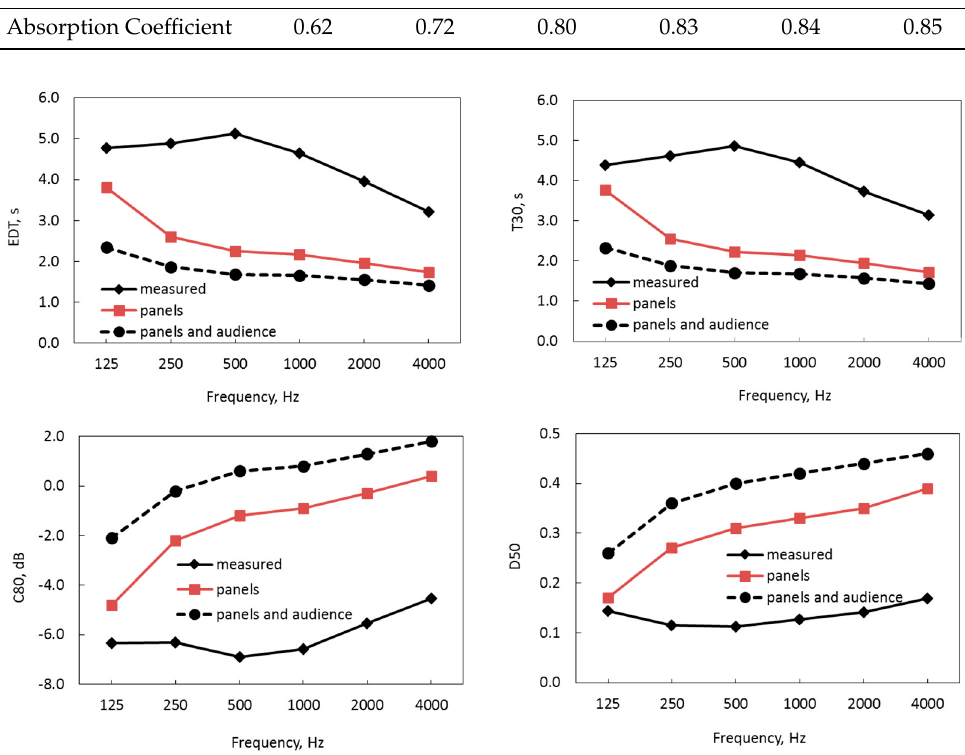
Figure 10. Acoustic parameters measured in comparison with acoustic absorbent systems and the presence of audience included in the virtual model. Table 4. Sound absorption coefficient of the audience.